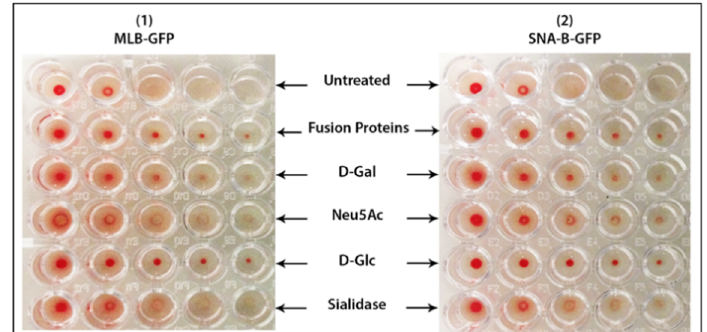
Figure 7. Hemagglutination assay using sheep erythrocytes. First row, untreated erythrocytes; second row, erythrocytes dosed with untreated MLB-GFP ( 1 ) and SNA-B-GFP ( 2 ) fusion proteins; third row, erythrocytes dosed with MLB-GFP + Sialic acid ( 1 ) and SNA-B-GFP + Sialic acid ( 2 ); fourth row, erythrocytes dosed with MLB-GFP + Galactose ( 1 ) and SNA-B-GFP + Galactose ( 2 ); fifth row, erythrocytes dosed with MLB-GFP + Glucose ( 1 ) and SNA-B-GFP + Glucose ( 2 ); sixth row, sialidase treated erythrocytes dosed with MLB-GFP ( 1 ) and SNA-B-GFP ( 2 ) fusion proteins.